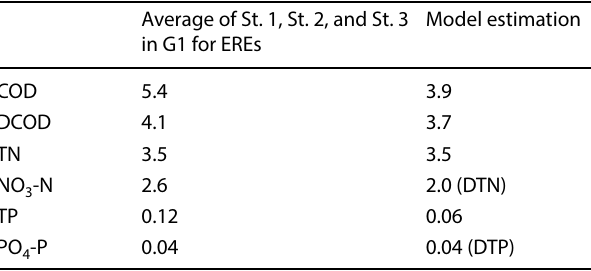
Table 5 The observed water quality during extreme rainfall events (the present study) (mg l −1 ) versus the water quality predicted by the runoff model (mg l −1